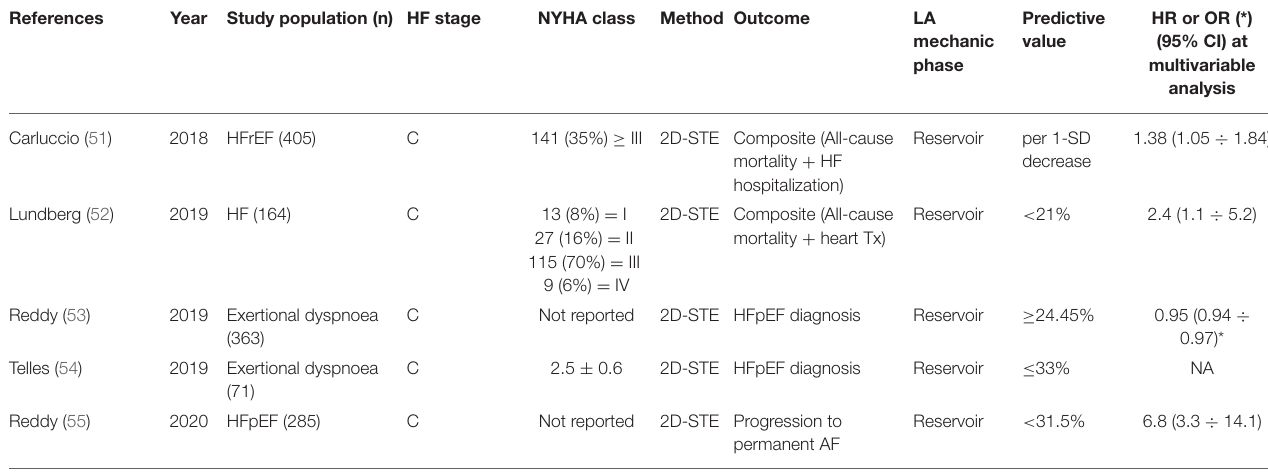
TABLE 3 | Summary of studies showing the prognostic value of LA mechanics in HF (stage C) with respect to hard and soft